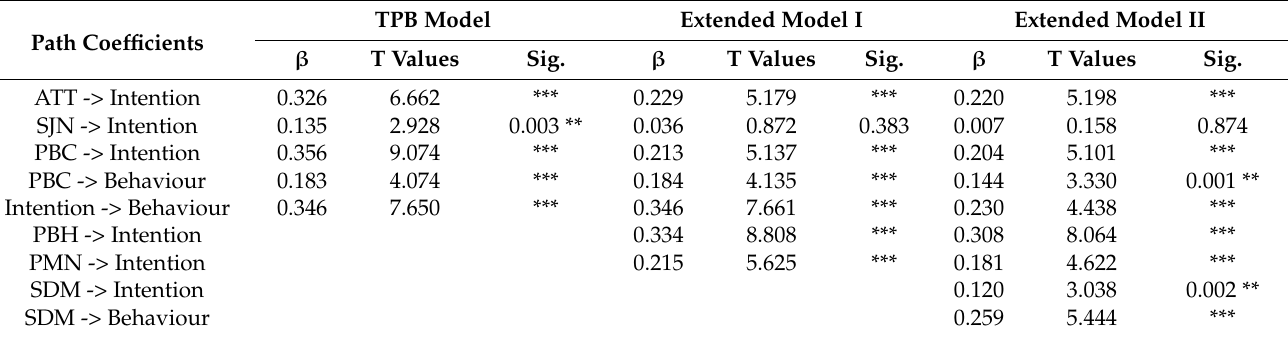
Table 6. Structural modelling analysis